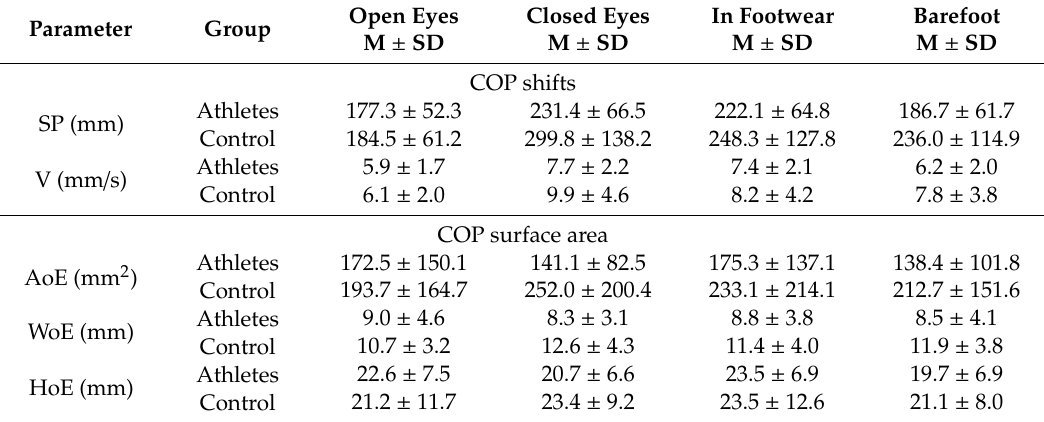
Table 3. Means and standard deviations for posturographic measures recorded under four conditions in pentathletes and